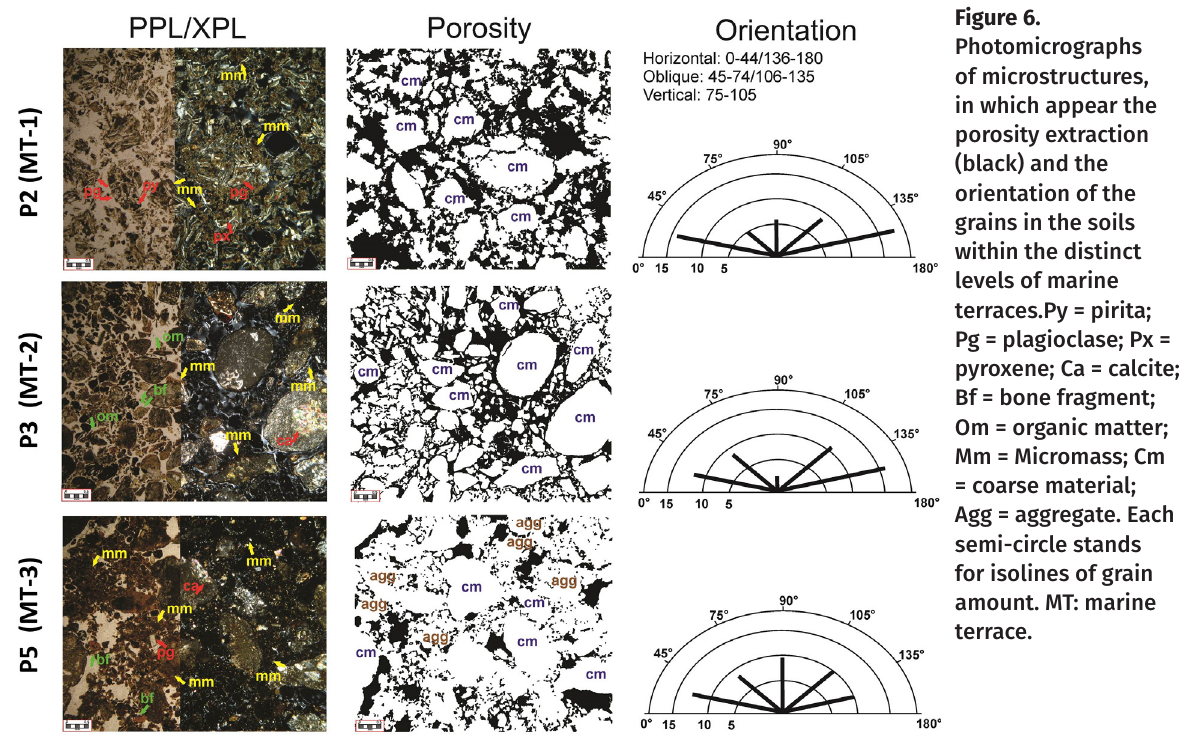
Figure 6. Photomicrographs of microstructures, in which appear the porosity extraction (black) and the orientation of the grains in the soils within the distinct levels of marine terraces.Py =